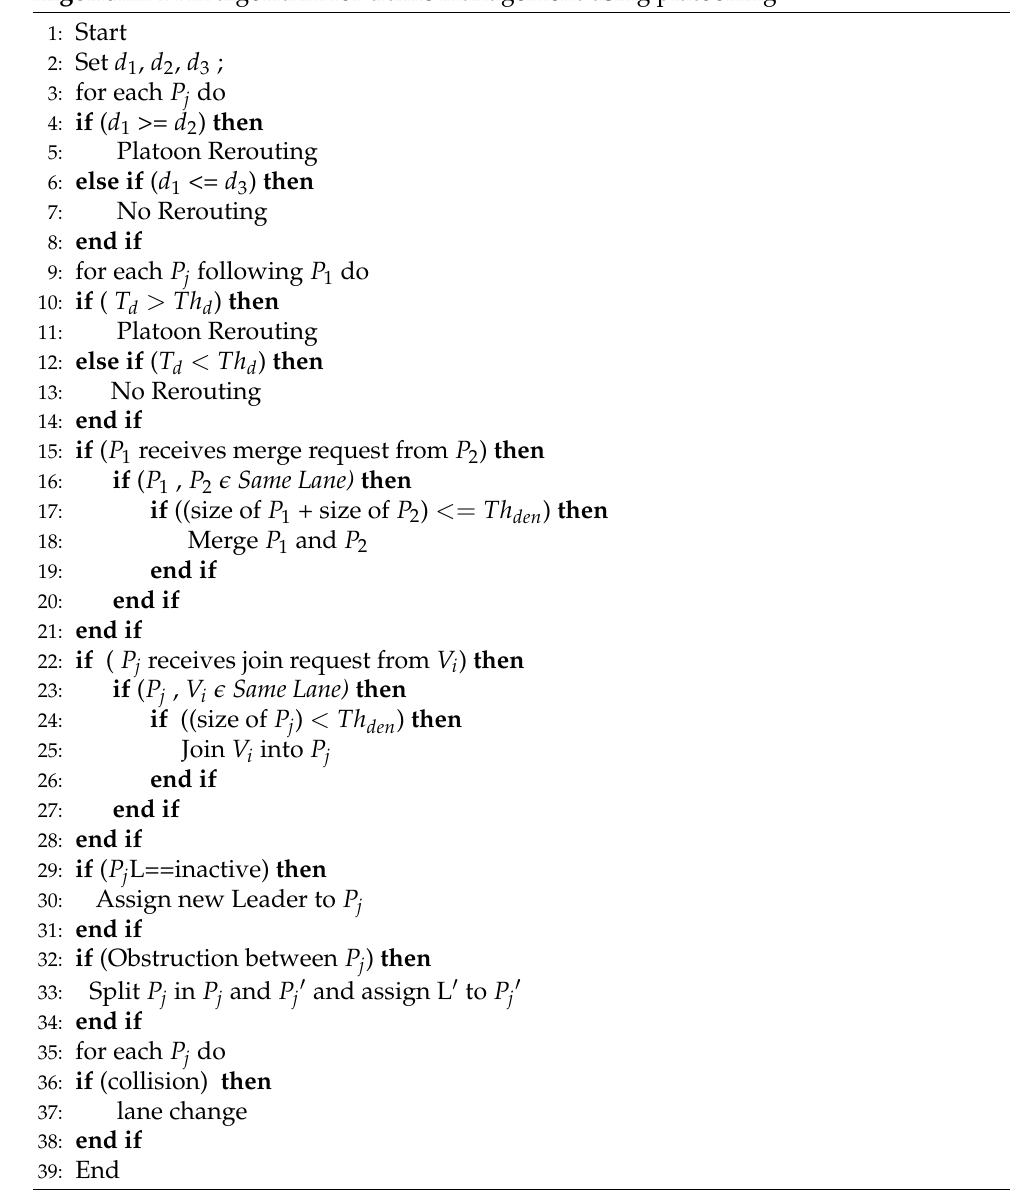
Algorithm 1 An algorithm for traffic management using